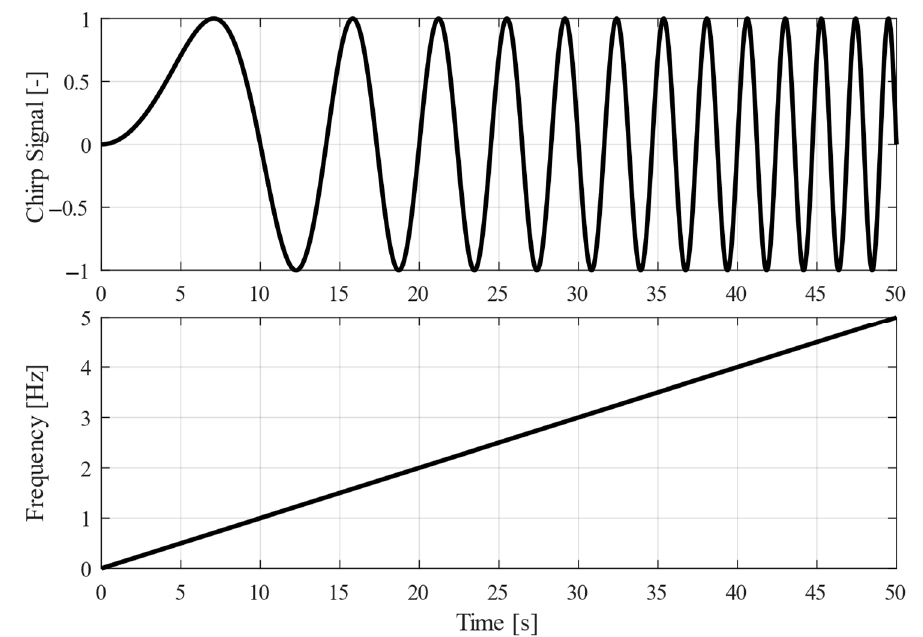
Figure 12. Chirp signal used for simulations.